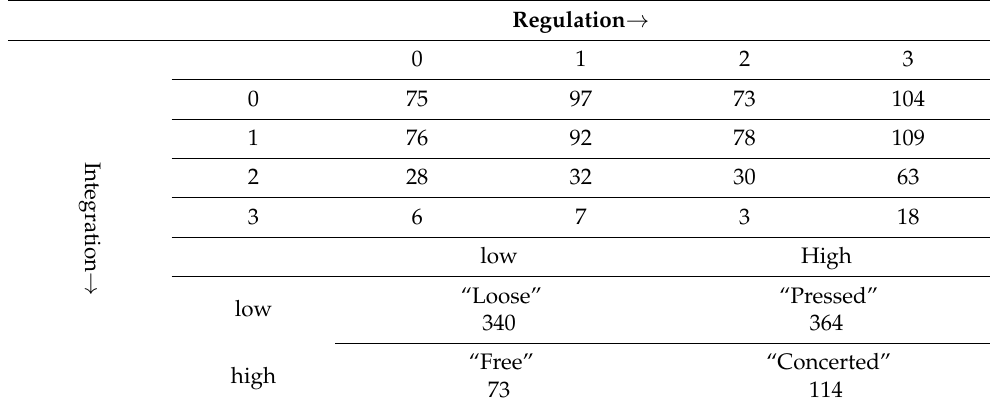
Table 2. Number of people by levels of regulation and integration in the family sphere.